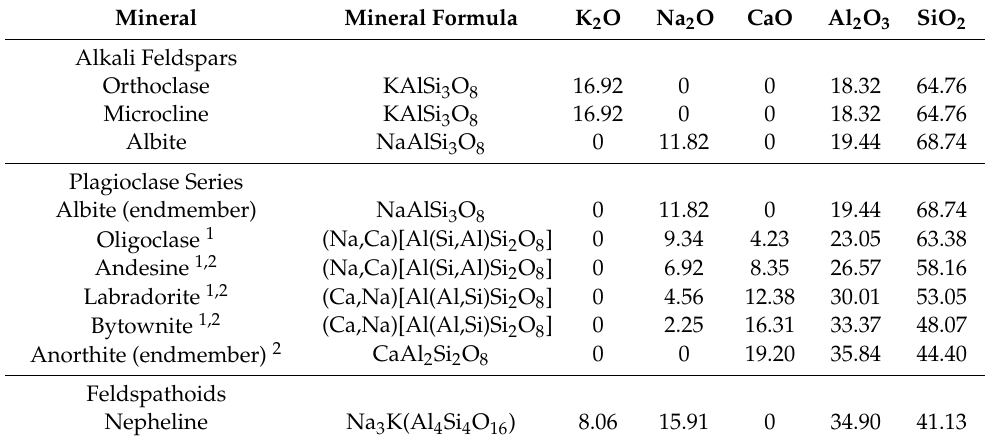
Table 1. Industrially used feldspars and feldspathoid minerals and their theoretical composition [26,27]. Mineral Mineral Formula K 2